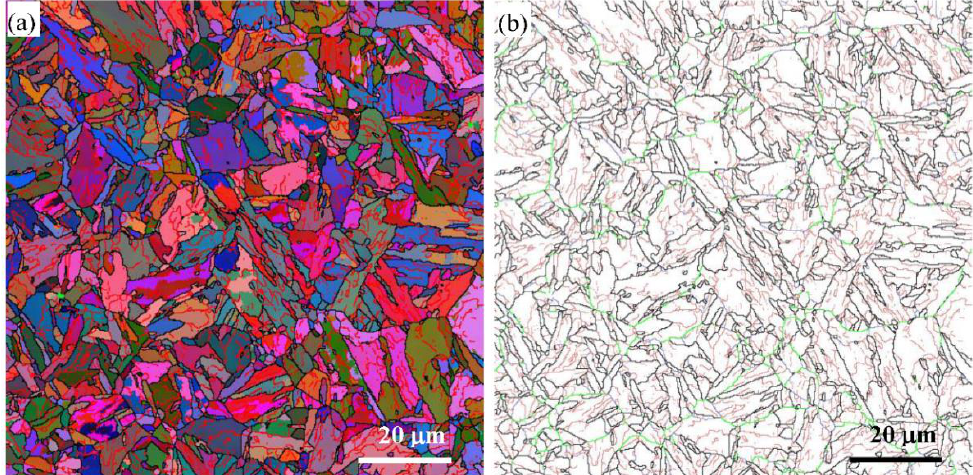
Figure 2. Typical electron backscatter diffraction (EBSD) images of the reduced activation steel before SMAT: ( a ) EBSD orientation color map and ( b ) corresponding boundary misorientation map. The fine red lines mark boundaries with misorientation between 2° and 15°, and the fine blue lines mark boundaries with misorientation between 15° and 30°; while the thick green lines mark boundaries with misorientation between 30° and 45°, and the thick black lines mark boundaries with misorientation larger than 45°.